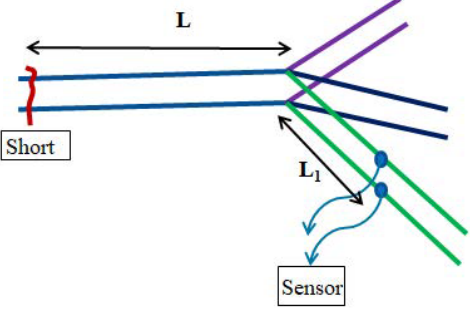
Figure 22. The sensor is on a bifurcation of the transmission line.